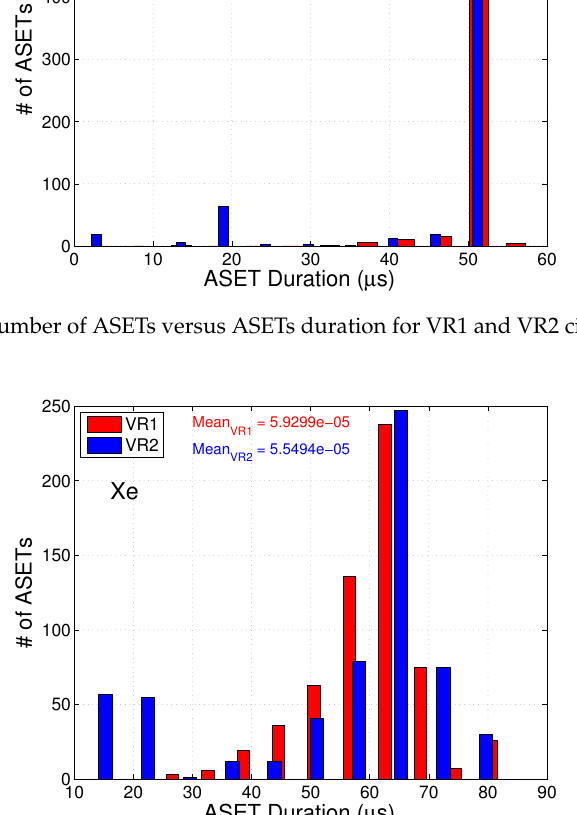
Figure 8. Measured number of ASETs versus ASETs duration for VR1 and VR2 circuits when exposed to Xenon.